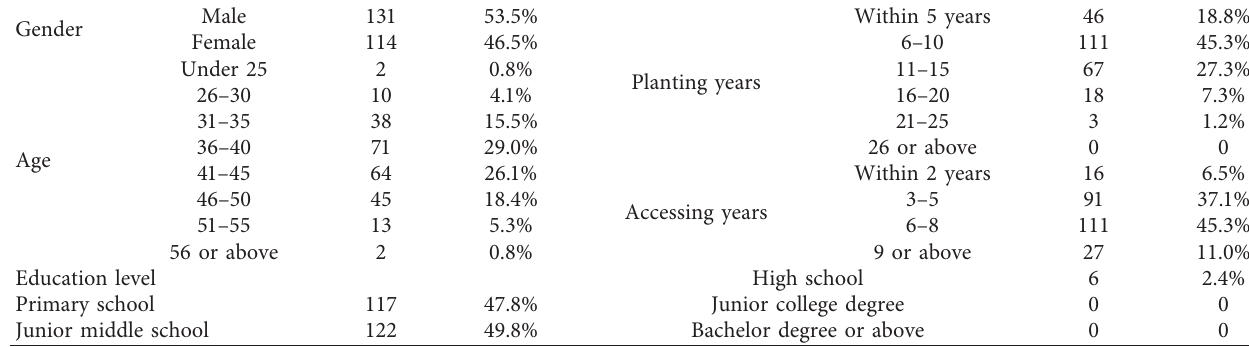
Table 1: Descriptive statistics of sample